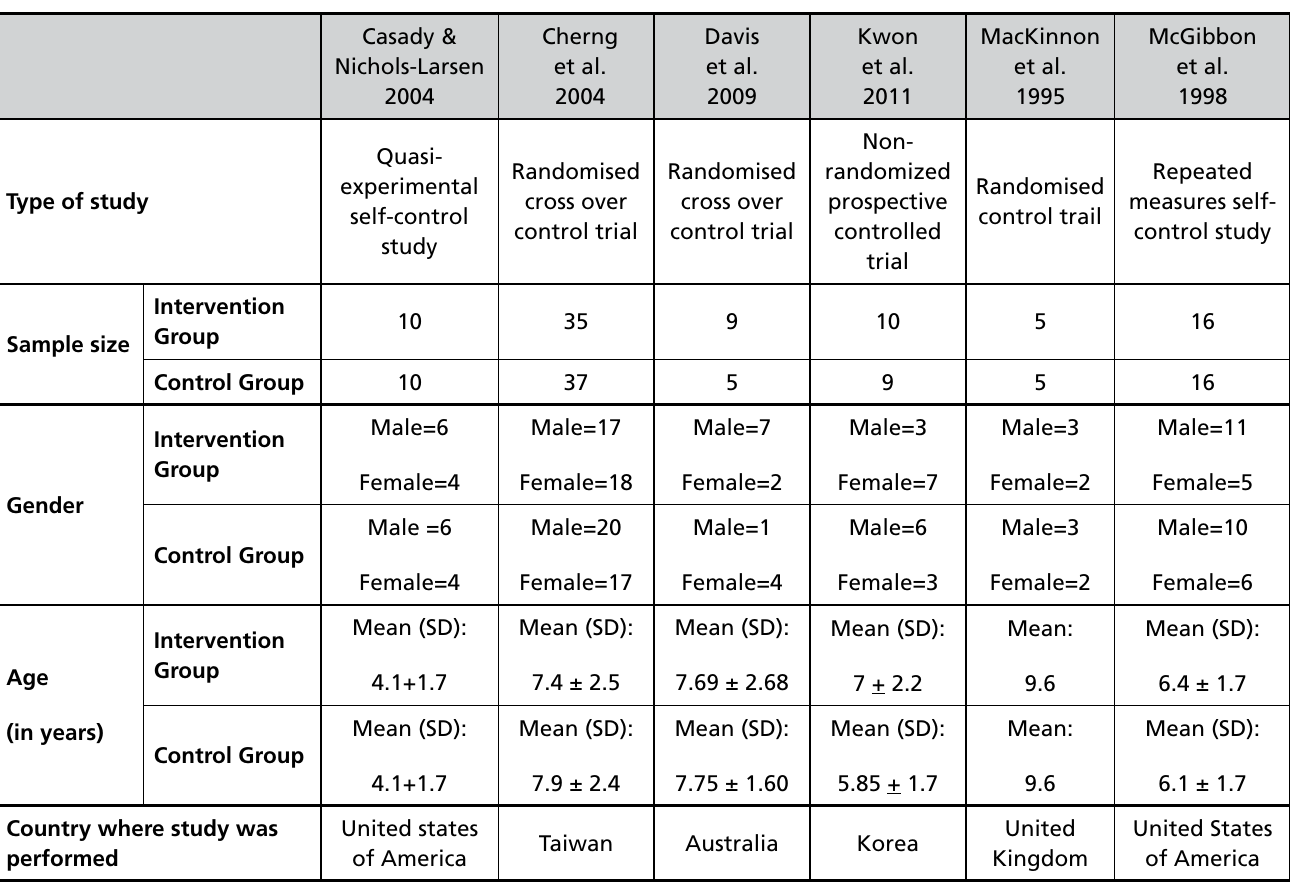
table 2: study sample